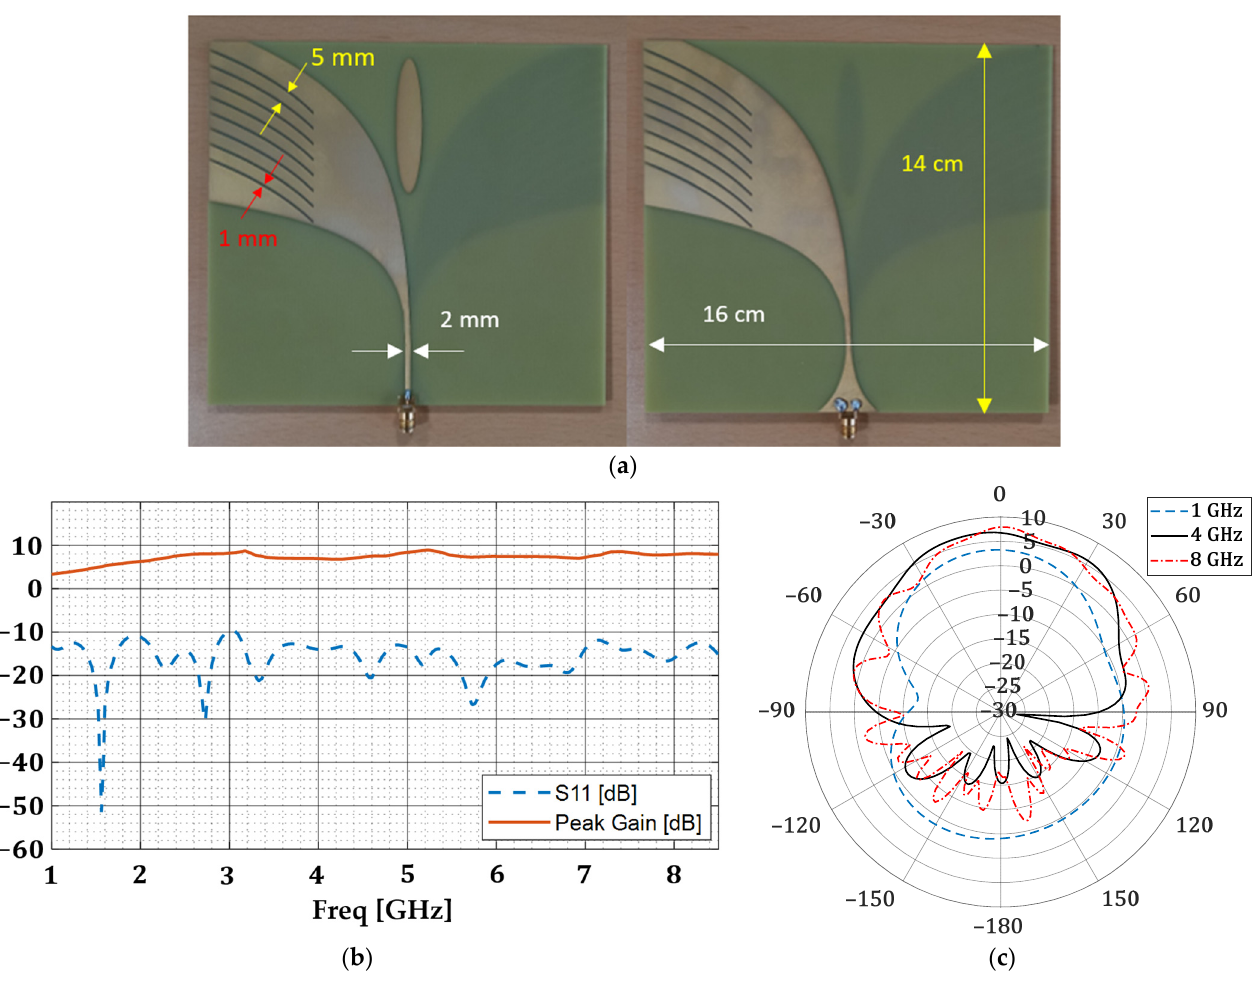
Figure 10. ( a ) Top and bottom layer of the fabricated antipodal Vivaldi antenna. ( b ) Antenna S 11 and peak gain in dB. ( c ) Antenna gain (dB) in the H ‐ plane